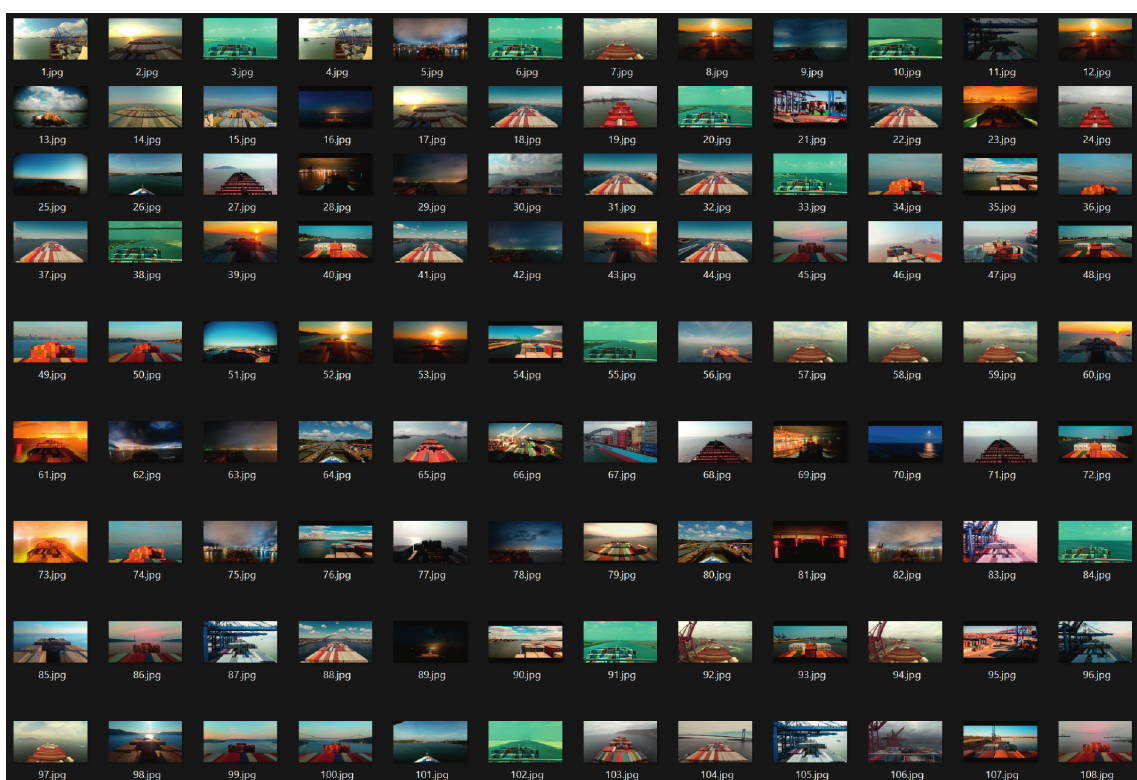
Figure 3: An example of onboard visual navigation dataset.